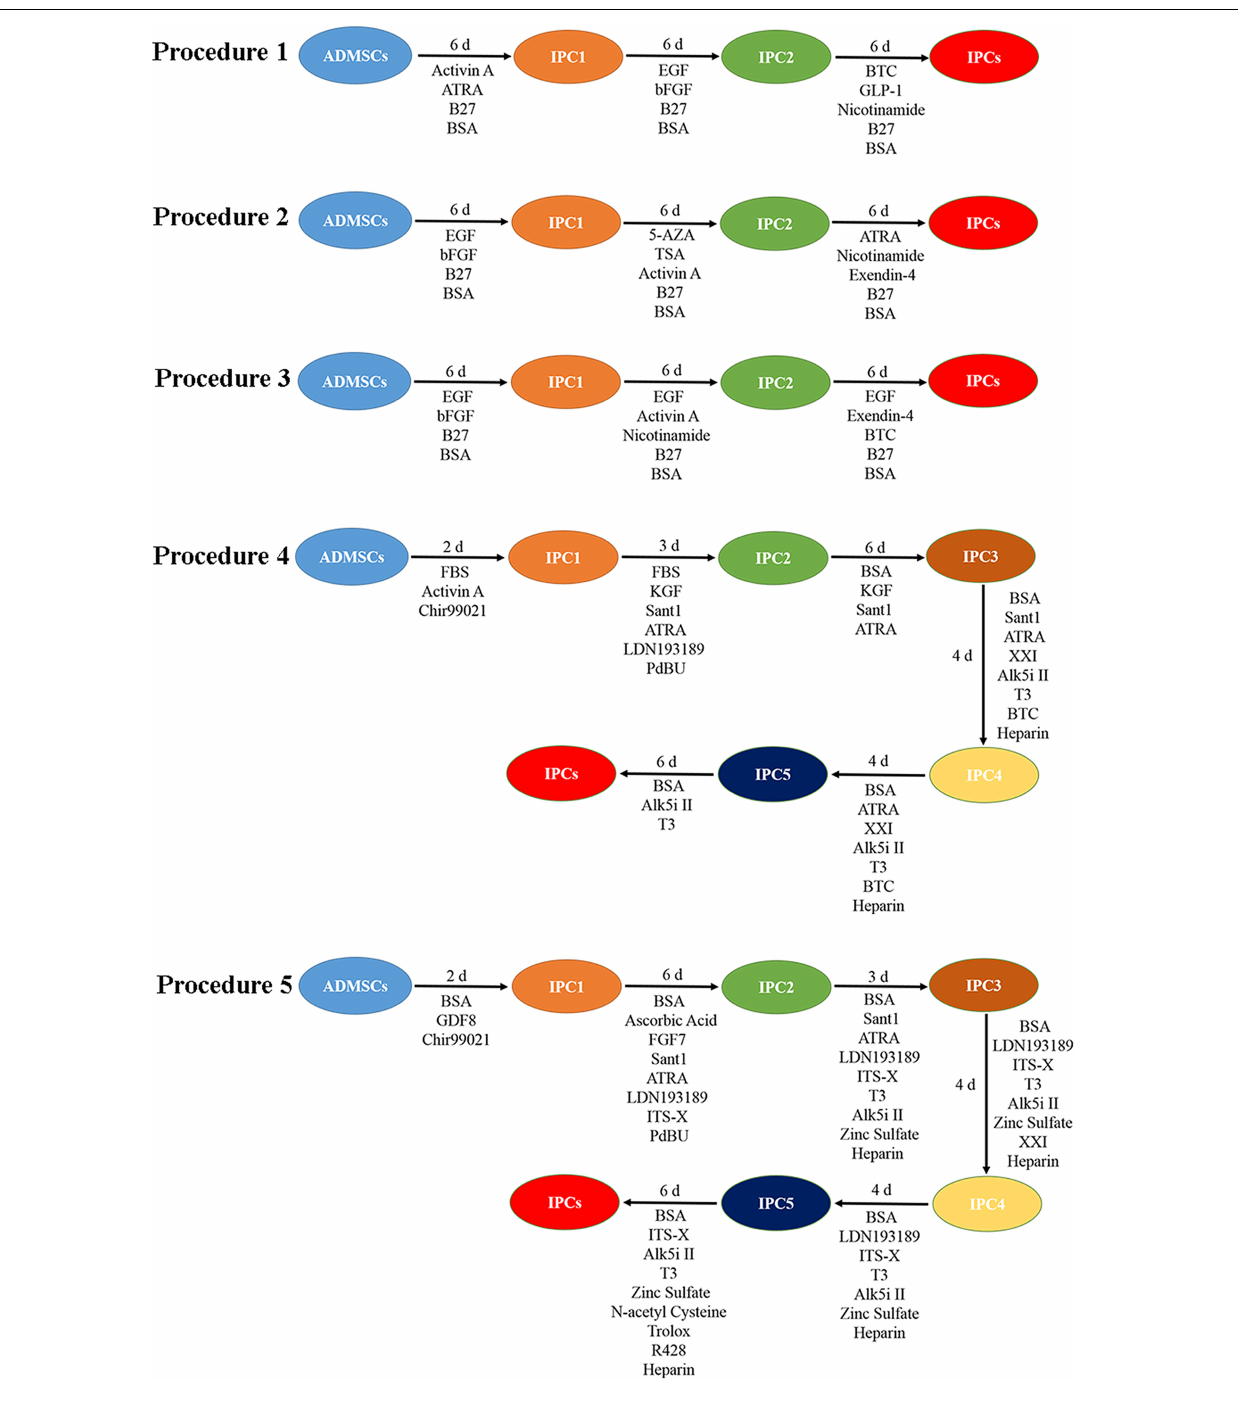
FIGURE 1 | The five types of